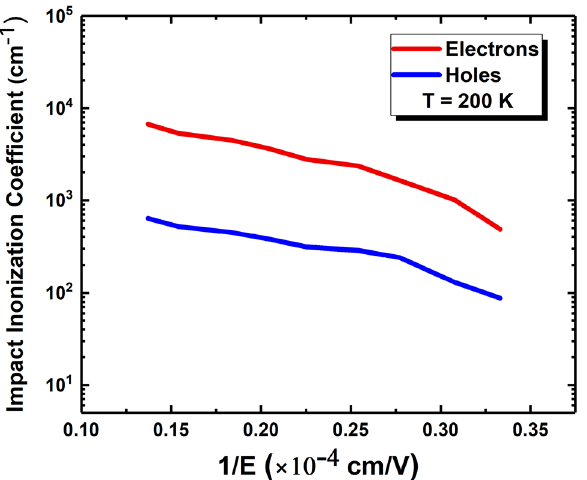
Figure 6. Electron and hole impact ionization coefficients for the MWIR SAM-APD vs inverse of electric field at 200